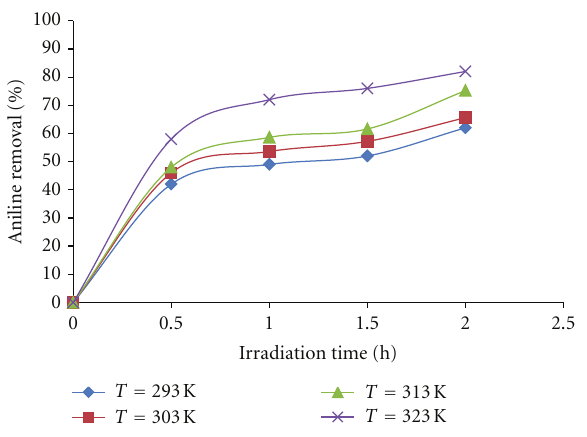
Figure 6: E ff ect of temperature on aniline removal (initial pH: 6, catalyst concentration: 60 mg/L).